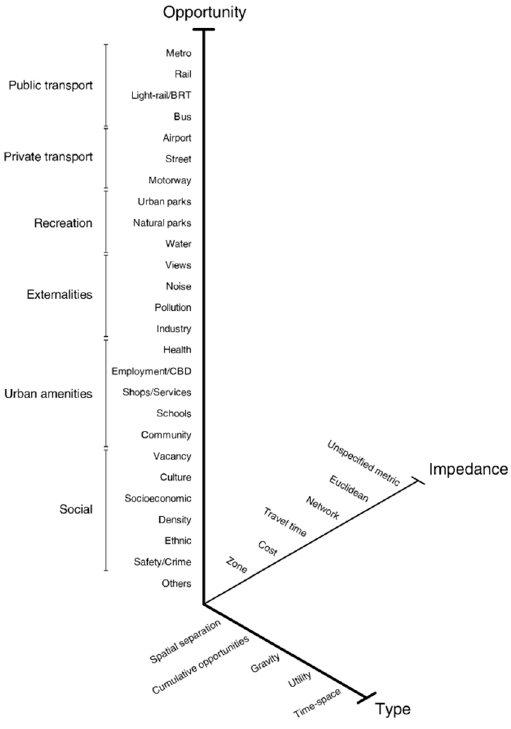
Figure 2. The three aspects of accessibility measures that are investigated is type, opportunity, and impedance. This figure shows the aspects and their units.